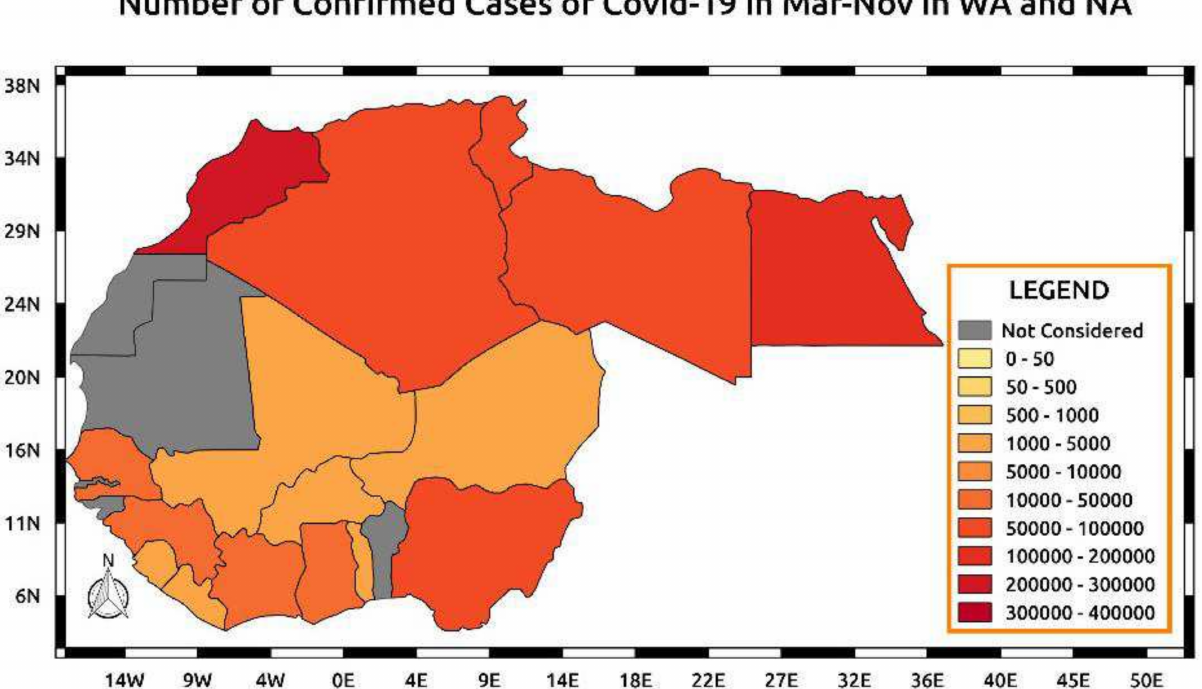
Figure 2. Spatial patterns of the total number of COVID-19 confirmed cases from 1 March to 30 November 2020 over all the considered countries. The countries were selected based on their high population density and the regularity of the reported daily positive